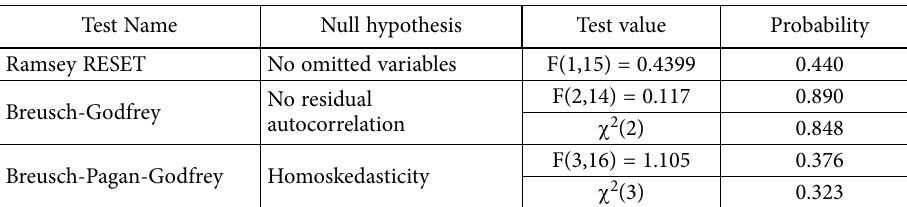
Table 5. Eq. (9) diagnostic tests (source: authors’ own